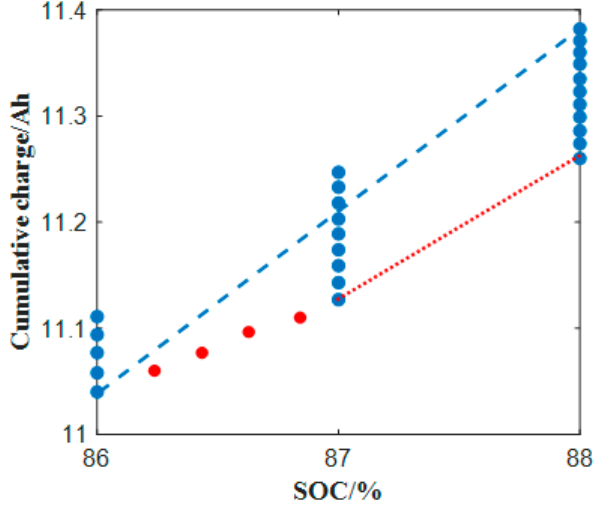
Figure 1. SOC Resolution optimization strategy.